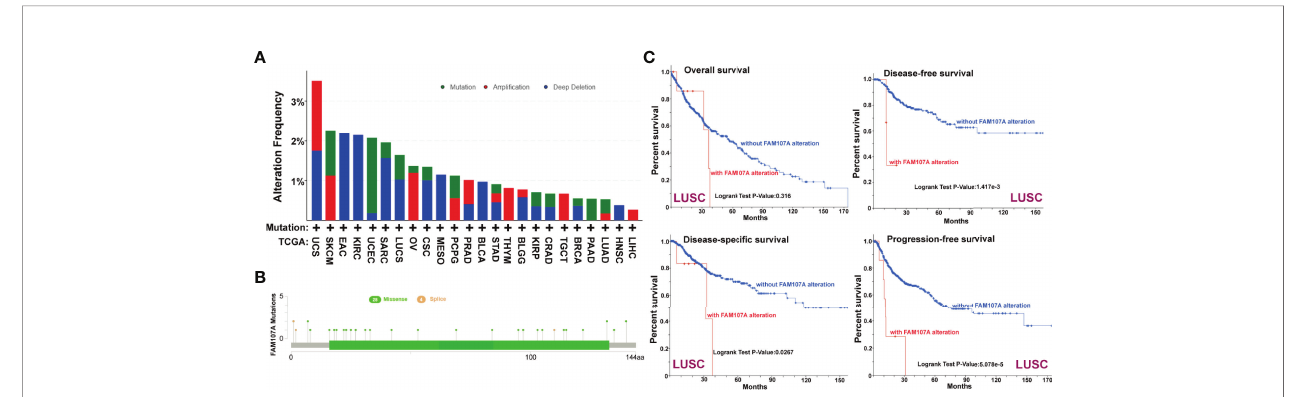
FIGURE 3 | Genetic alteration of FAM107A in different tumors of TCGA. We analyzed the mutation features of FAM107A for the TCGA tumors using the cBioPortal tool. (A) The alteration frequency with mutation type of FAM107A was analyzed via cBioPortal tool. (B) The mutation sites of FAM107A gene were investigated using the cBioPortal tool. (C) The potential correlation between mutation status and overall, disease-speci fi c, disease-free and progression-free survival of LUSC was analyzed with the cBioPortal